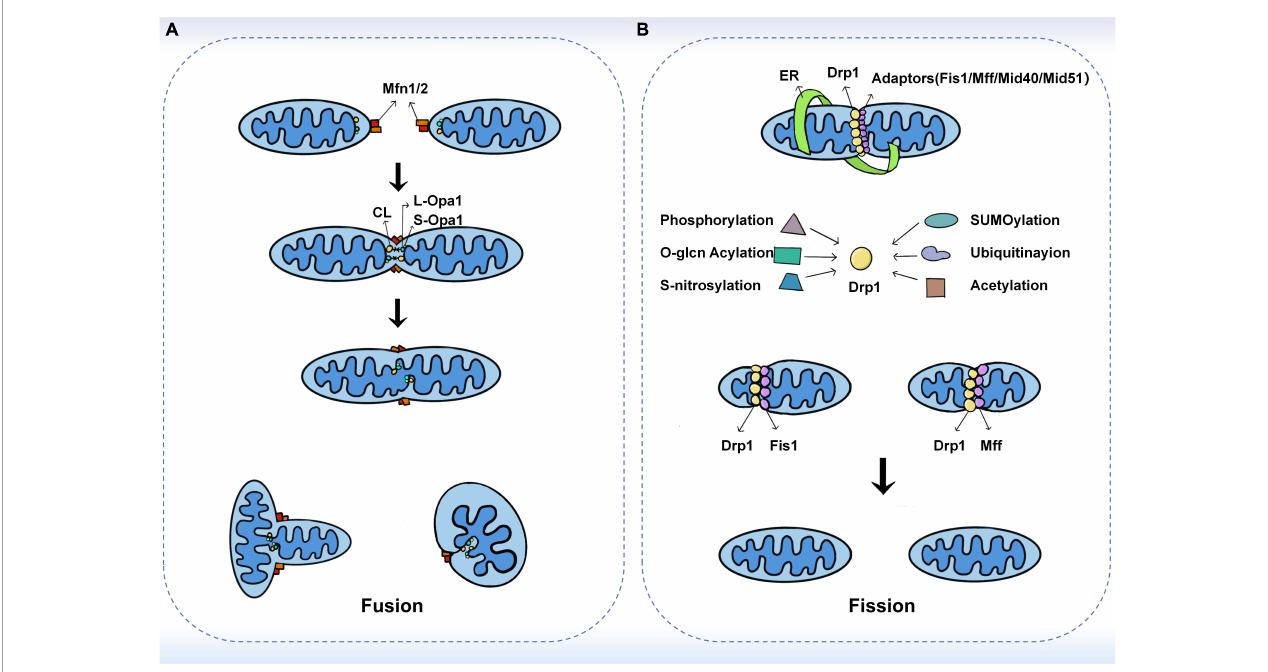
FIGURE1 The fusion and fission machinery. (A) The mechanisms of mitochondrial fusion. Mfn1/2 mediate outer membrane fusion. Opa1 mediates inner membrane fusion and maintains cristae structure. Under stress, L-Opa1 is activated and S-Opa1 can regulate the fusion activity of L-Opa1. (B) The mechanisms of mitochondrial fission. Drp1 plays a central role in mitochondrial fission. Several kinds of post-translational modifications of Drp1 may affect the recruitment of Drp1 from the cytoplasm. The adaptors including Fis1, Mff, MiD49, and MiD51 also have substantial roles in the recruitment of Drp1 to